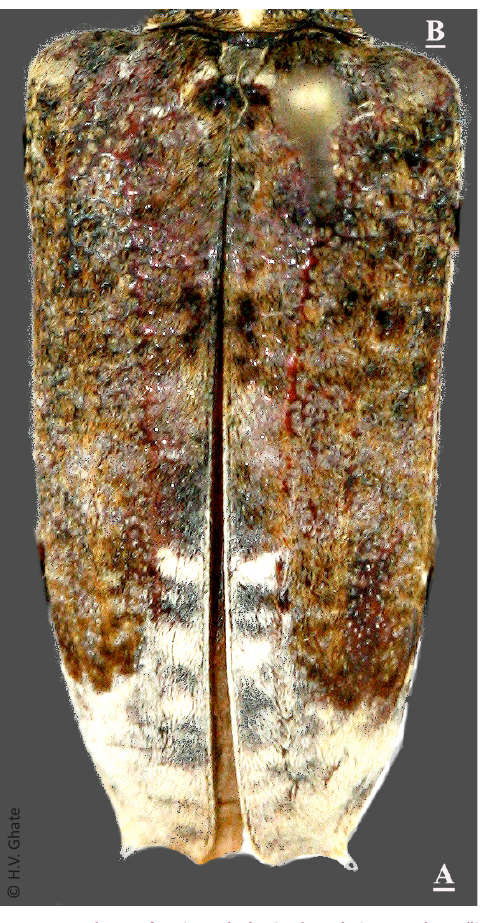
Image 10. Elytra of Apiocephalus in dorsal view to show ‘lichen- growth’ like pattern of pubescence. A - Apex; B - Base